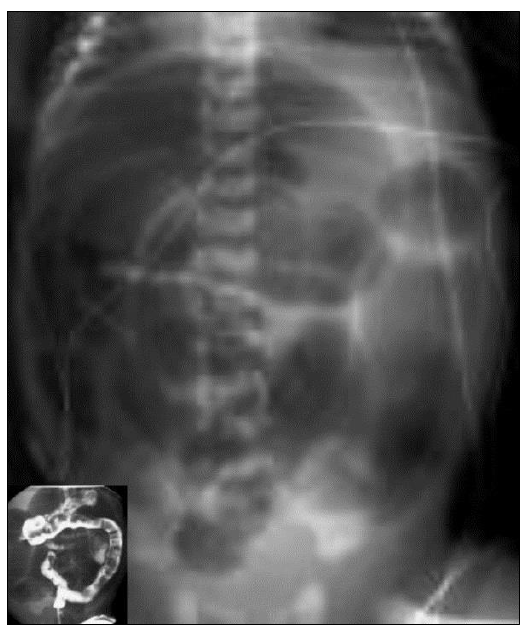
Figure 12: X-ray showing dilated bowel loops. Contrast enema showed filling defects seen in meconium plug